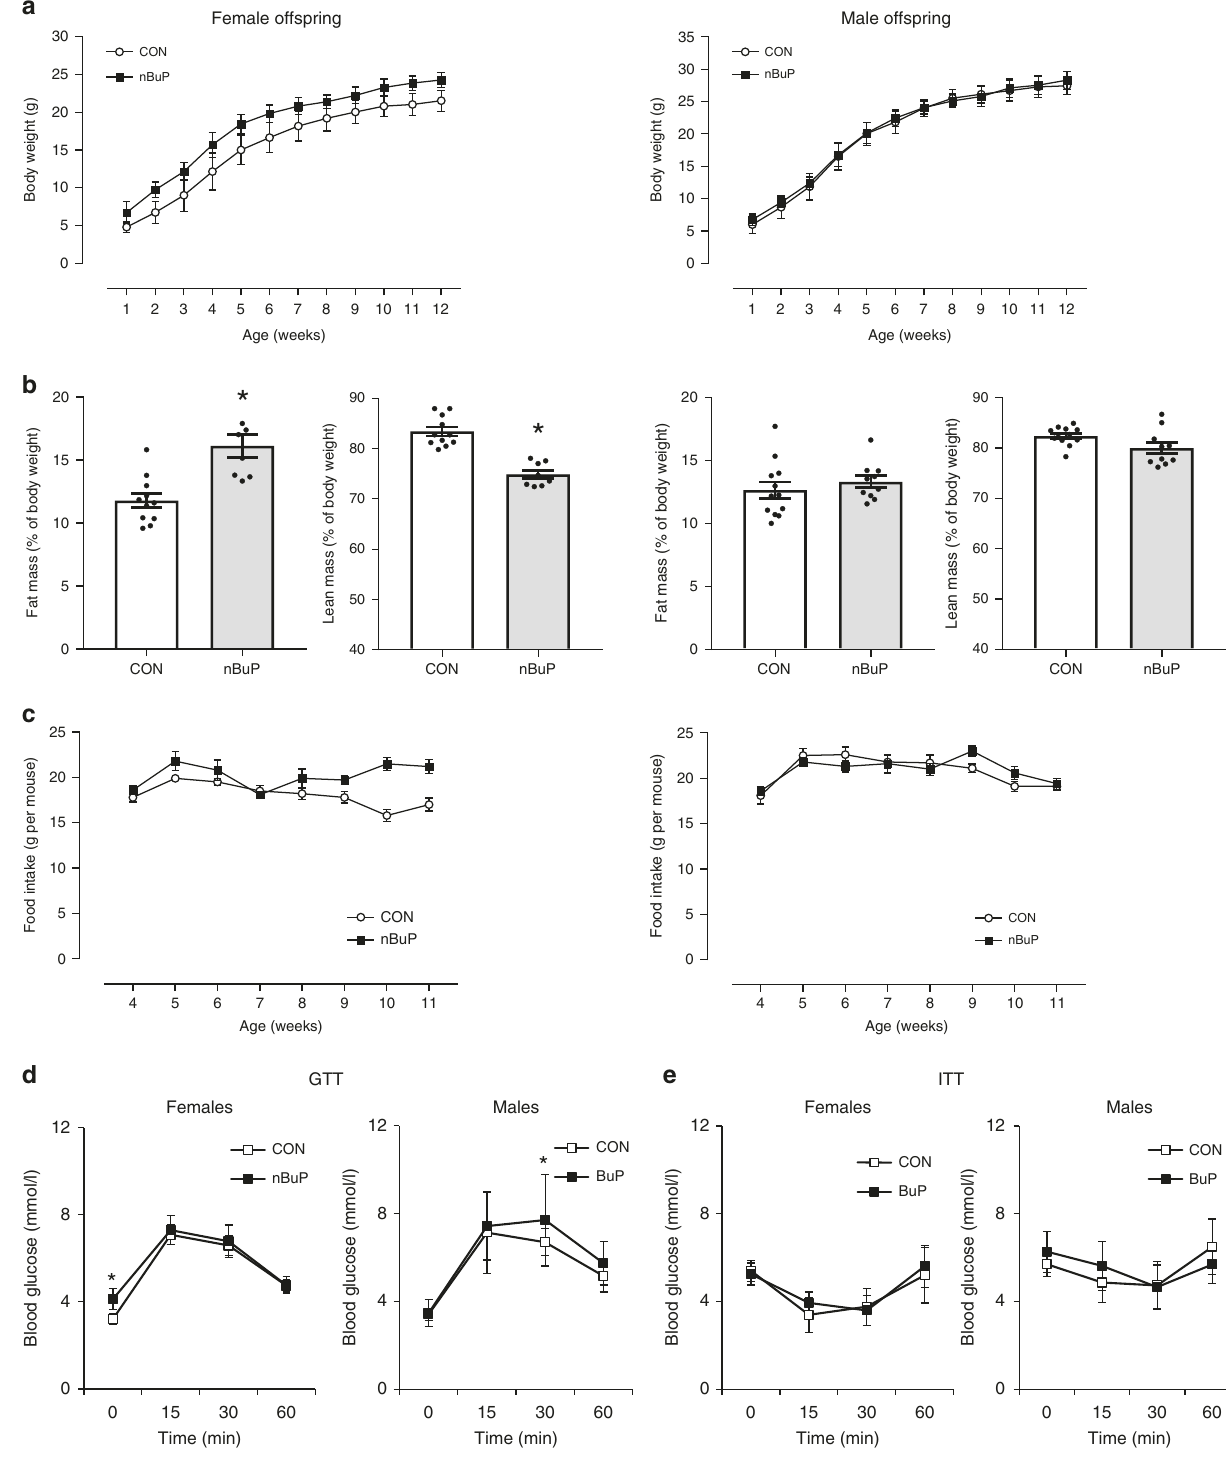
Fig. 2 Perinatal exposure to nBuP and weight development, food intake and glycose metabolism in the offspring. a Bodyweight development, (CON: n = 18, nBuP: n = 16), b body composition (CON: n = 11, nBuP: n = 9) and c food intake (CON: n = 10 , nBuP: n = 6 ) are shown from female (left) and male offspring (right) from nBuP-exposed dams, d Glucose tolerance test (GTT, CON: n = 18, nBuP: n = 10) and e insulin tolerance test (ITT, CON: n = 15, nBuP: n = 10) were performed in 9-weeks old offspring. Data are expressed as mean ± SEM, * P < 0.05, unpaired t -test. For longitudinal analysis GEE models were applied ( a female mice β = 3 g, SE = 0.5 g, p = 5.3 × 10 − 9 , male mice β = 0.5 g, SE: 0.6 g, p = 0.34; c female mice β = 0.5 g per week SE: 0.2 g, p = 0.006, male mice β = 0.25 g per week, SE = 0.18, p = 0.17). Source data are provided as a Source Data fi